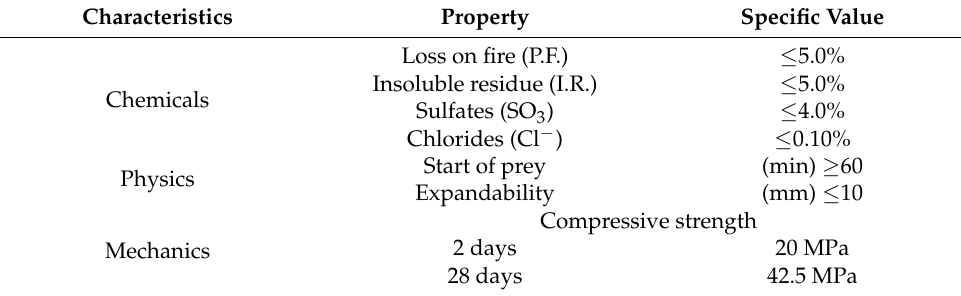
Table 1. Characteristics of CEM I 42.5 R cement.